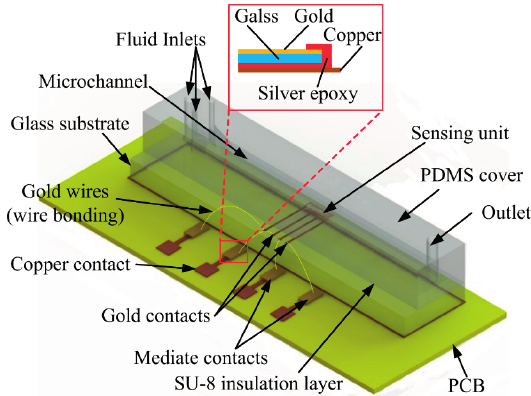
Figure 2. Schematics of the droplet sensor and connection to a PCB with mediate contacts (thin gold film on glass substrate). The inserted figure illustrates the electrical connection between the mediate contact and the copper contact on PCB through conductive silver epoxy.